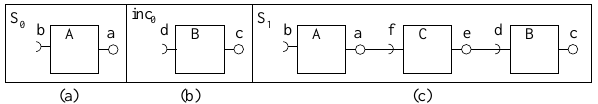
Figure 20. Components with incompatible ports: (a) Component, (b) Increment, and (c) System.